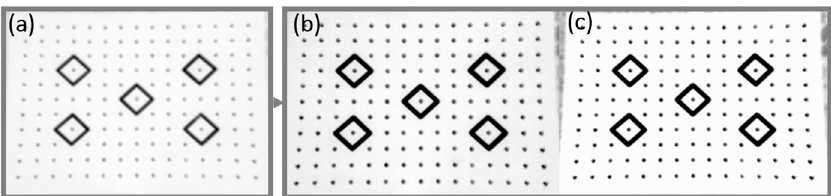
Figure 11. Contrast enhancement with use of histogram equalization method: ( a ) image without correction; ( b ) histogram equalization; ( c ) narrowing the temperature range.